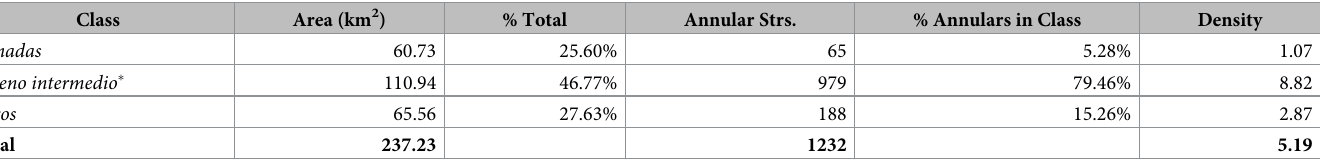
Table 8. Landforms and annular